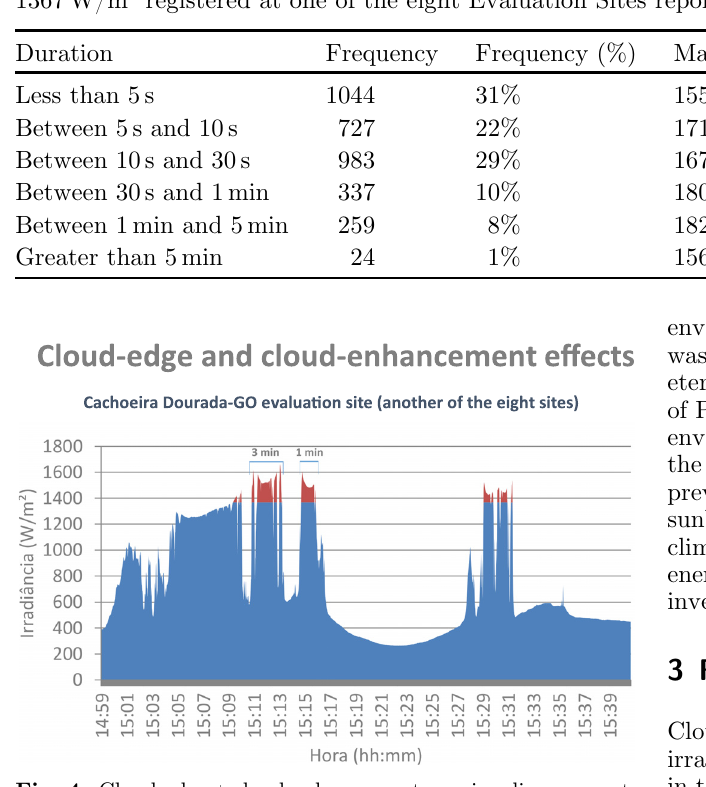
Fig. 3. Cloud-edge+ cloud-enhancement overirradiance events at one of the eight Evaluation Sites reported in this paper, in which an irradiance peak of 1823 W/m 2 was measured. Table 1. Overirradiance events and event duration for irradiance peaks at or above the extraterrestrial irradiance of 1367 W/m 2 registered at one of the eight Evaluation Sites reported in this paper.